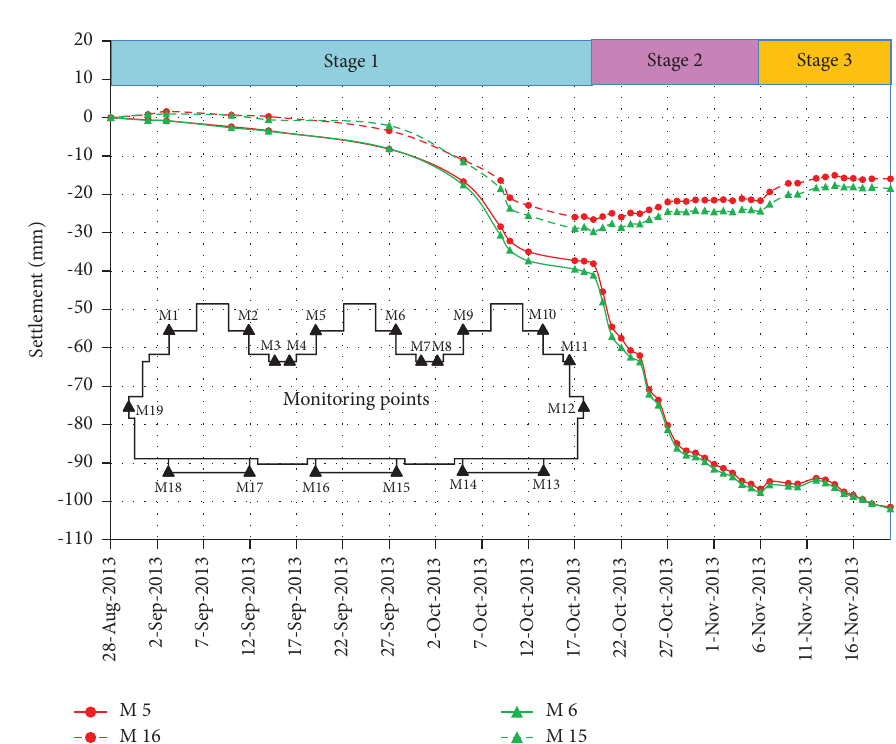
Figure 8: Settlement versus time of case